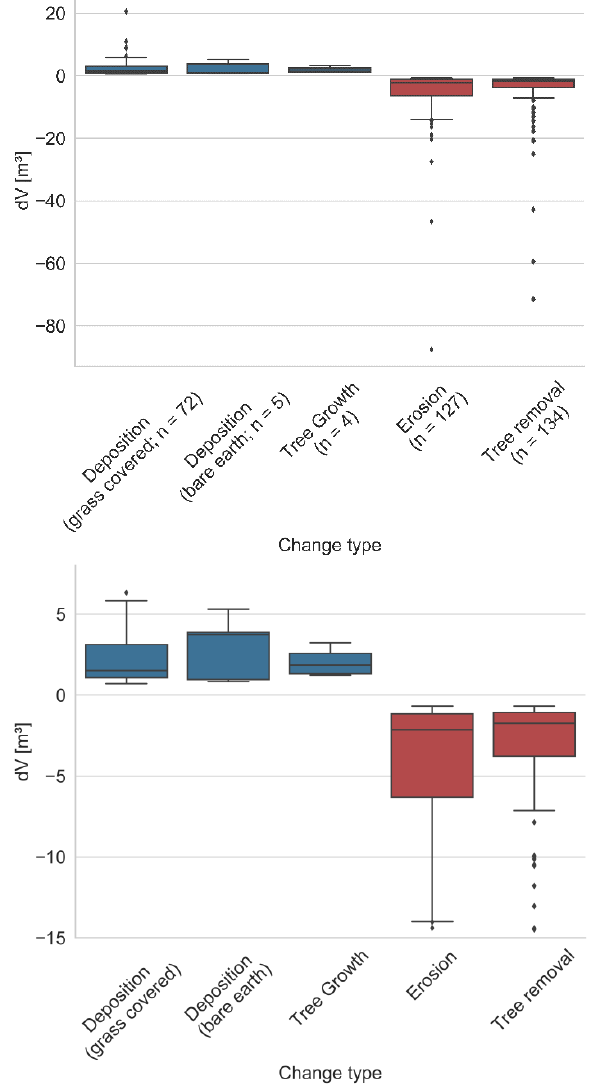
Figure 7. Changed volume (dV) per object for different types of change. Top: Full range of changes per object, including ex- treme values. Bottom: Changes per object only in the range between -15 m³ and 8 m³ (i.e. different y-axis